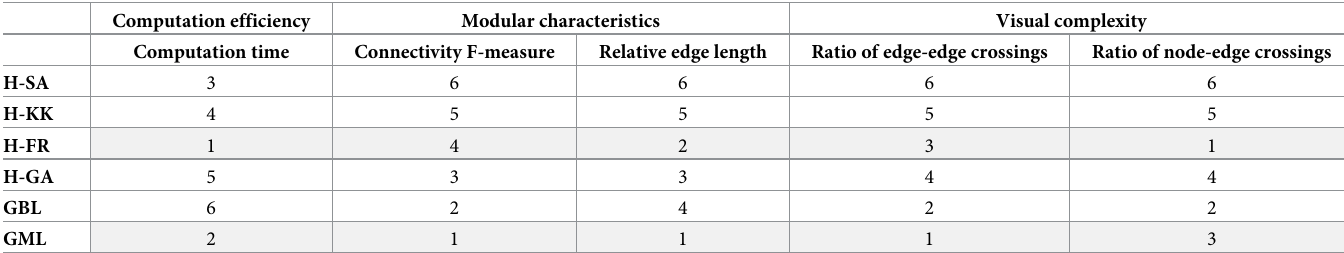
Table 3. Characterizations of selected